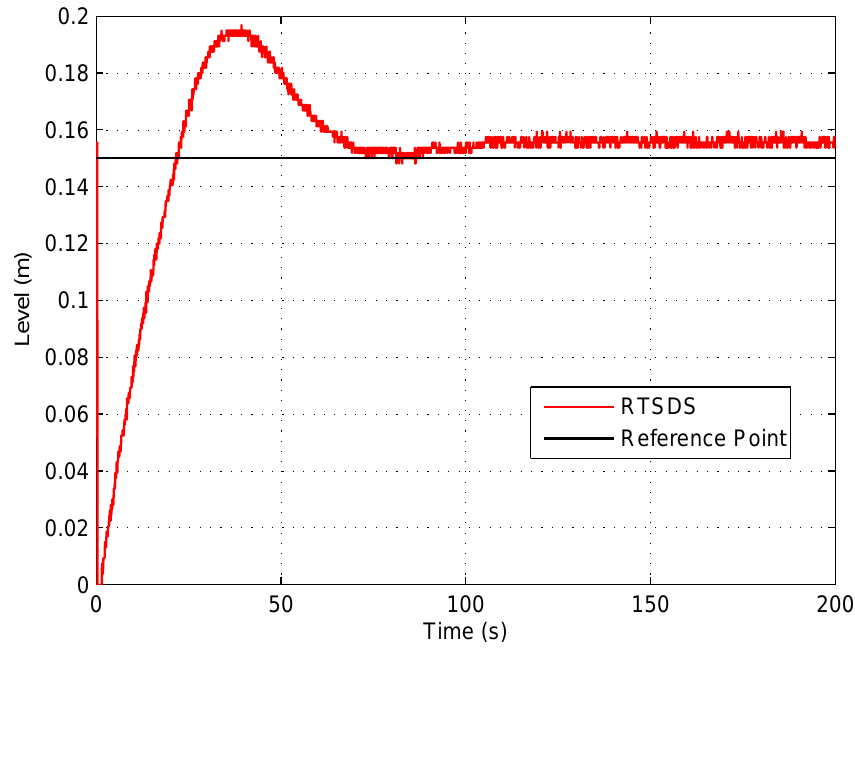
Figure 18. Results obtained for the RTSDS platform utilizing an external PID controller = 2 , k = 0 . 2 e k = 0 . 001 ) onboard an ATmega 2560 ( k p i d